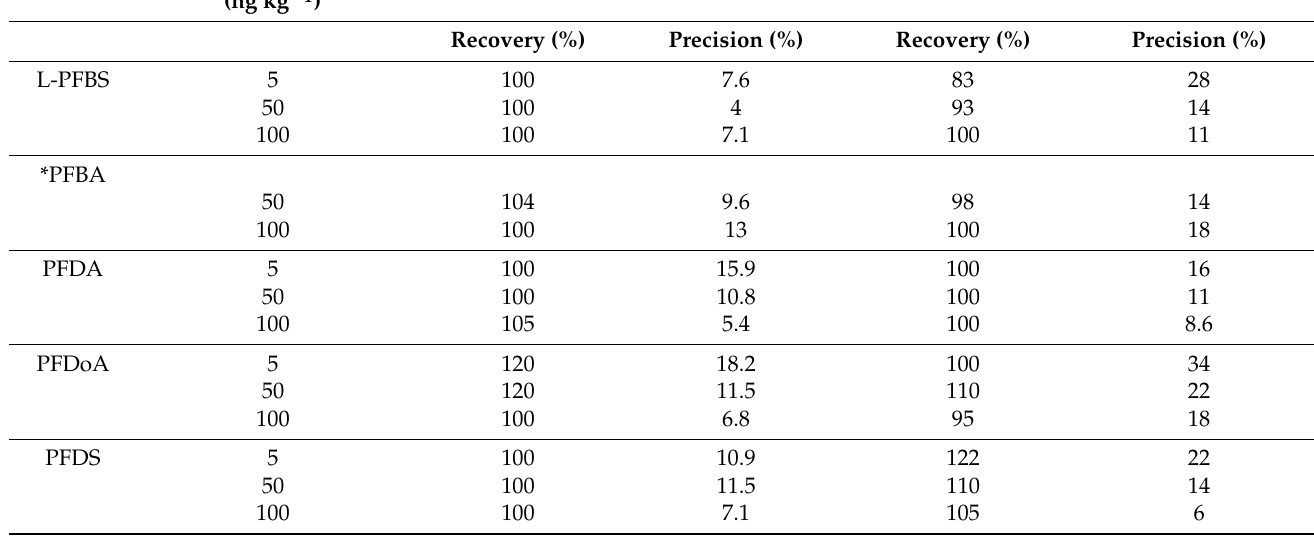
Table 2. Accuracy and precision of PFAS